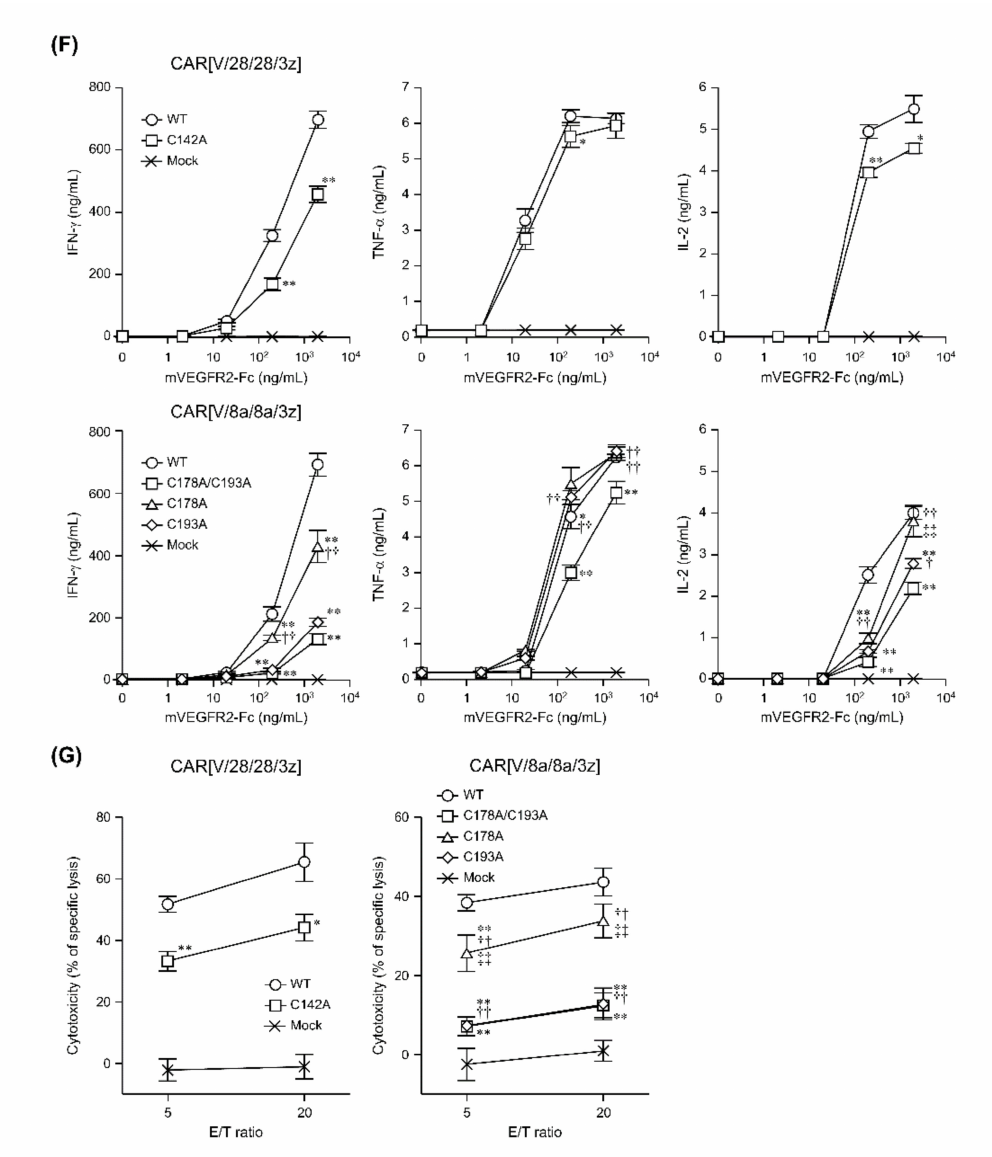
Figure 3. Influence on expression and antigen-specific function of CAR[V/28/28/3z] or CAR[V/8a/8a/3z] following deletion of the cysteine in HD. ( A ) SDS-PAGE and Western blotting analysis showing the expression modality of six CAR variants in whole CAR-T cell lysate on day 0. ( B ) The surface expression and antigen-binding ability were determined via FCM analysis on day 0. All cells were pre-gated with live cells, lymphocytes, and CD8 α + cell. ( C ) CAR mRNA expression was analysed via RT-qPCR, and their transcription levels were calculated relative to GAPDH mRNA as an endogenous control. ( D ) CAR expression on T cells was analysed via FCM. Each CAR expression level was calculated from the ratio of geometric mean fluorescence intensity (GMFI) when stained with the anti-HA-tag mAb to GMFI when stained with the isotype control antibody. ( E ) Proliferation activity of HD-modified CAR-T cells following mVEGFR2 stimulation. ( F ) Cytokine production ability of the above cells following mVEGFR2 stimulation. ( G ) Cytotoxic activity of the above cells four days after Rv transduction against mVEGFR2 + EL4 cells. The data were obtained from three independent tests. Statistical analysis was performed using Welch’s t -test (* p < 0.05 and ** p < 0.01 versus WT) in CAR[V/28/28/3z] or Tukey’s test (* p < 0.05 and ** p < 0.01 versus WT, † p < 0.05 and †† p < 0.01 versus C178A/C193A, ‡‡ p < 0.01 versus C193A) in